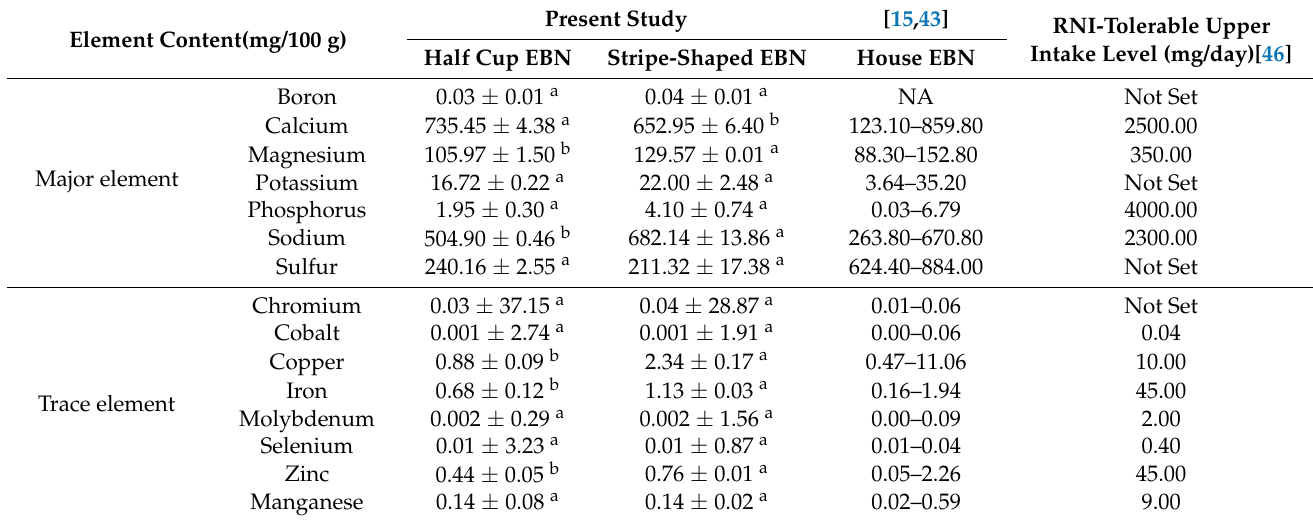
Table 4. Major and trace element (TE) content of the half cup and stripe-shaped